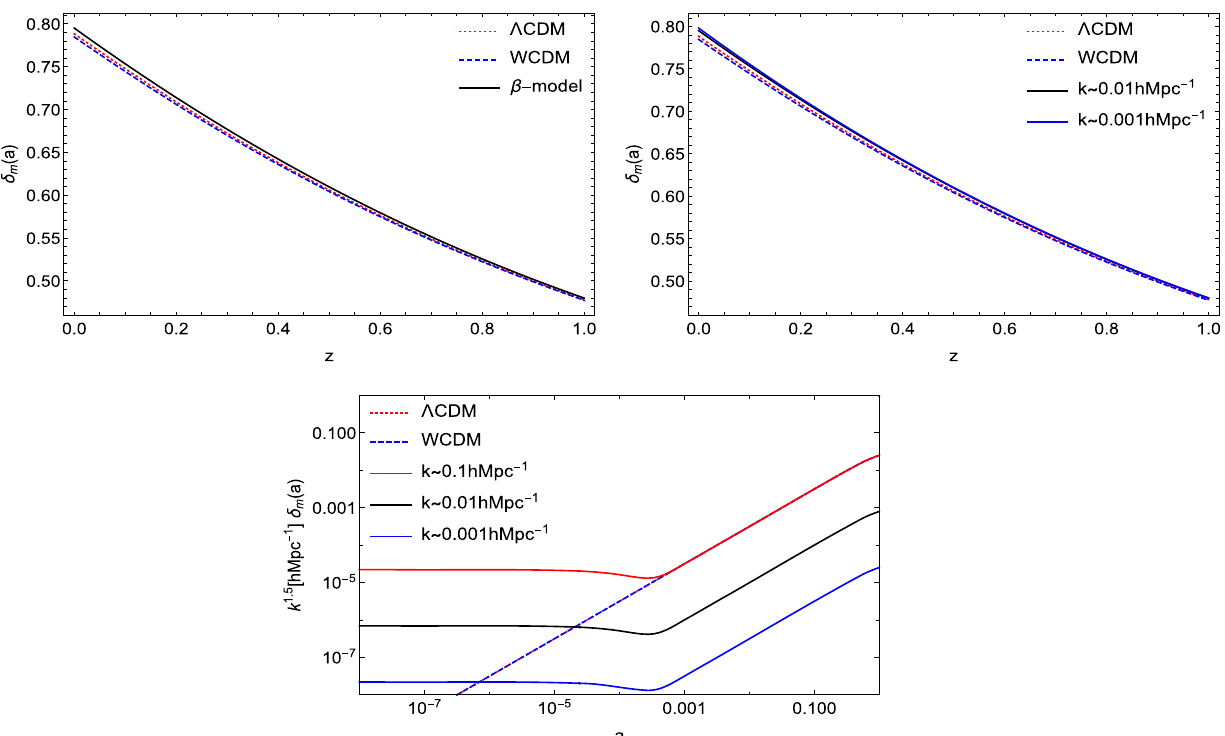
Fig. 1 Density growth profiles in different scales for the considered models. The values of the parameters were extracted from Table 2. Top left panel: Density growth in k ∼ 0 . 1h Mpc − 1 scale. Top right panel: Density growth in k ∼ 0 . 01h Mpc − 1 and k ∼ 0 . 001h Mpc − 1 scales.